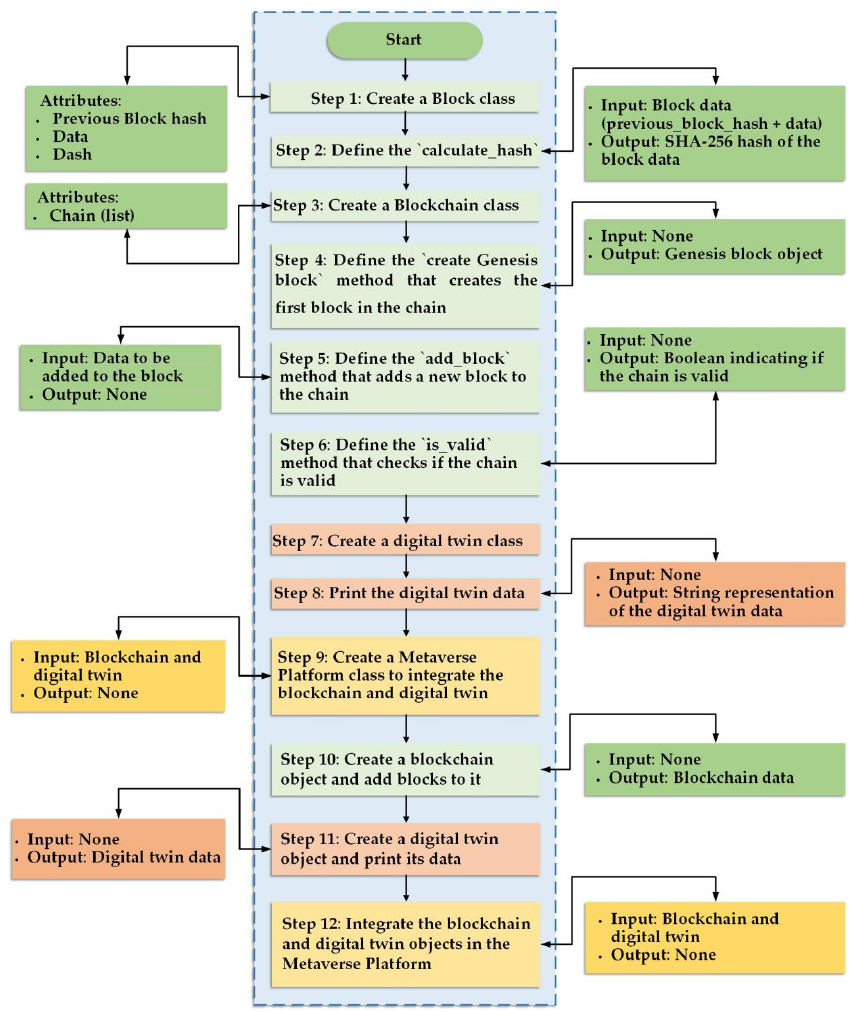
Figure 4. An illustration of a basic blockchain platform implementation for the system.